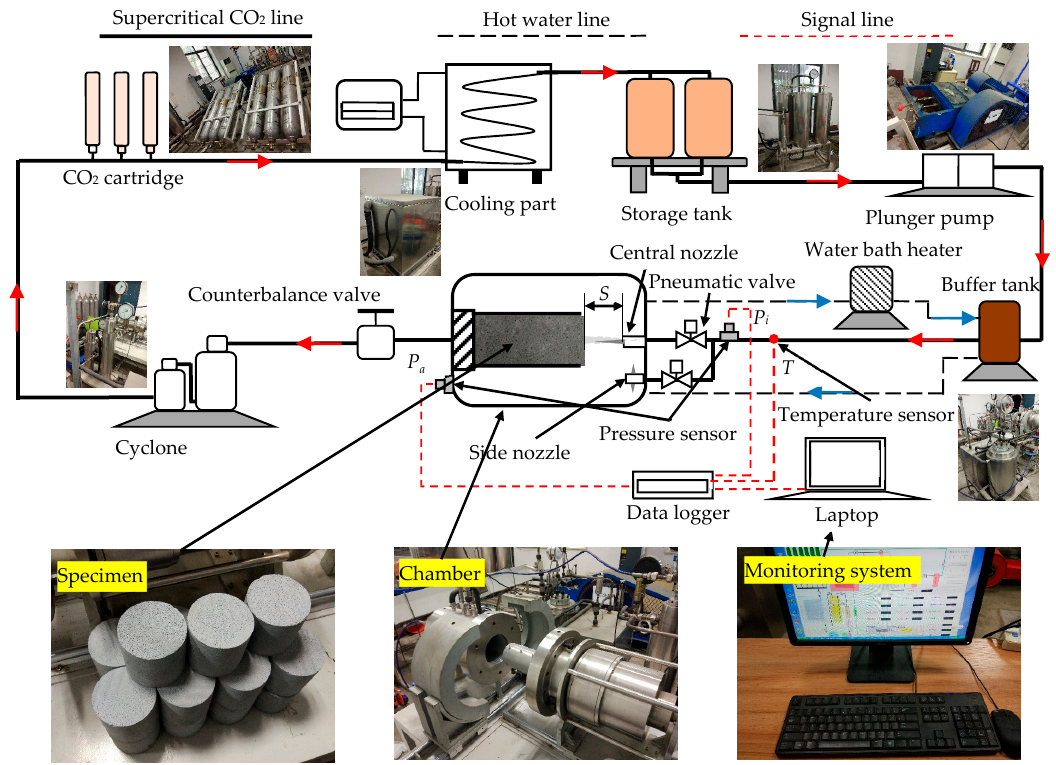
Figure 2. Schematic diagram of the rock erosion test system.